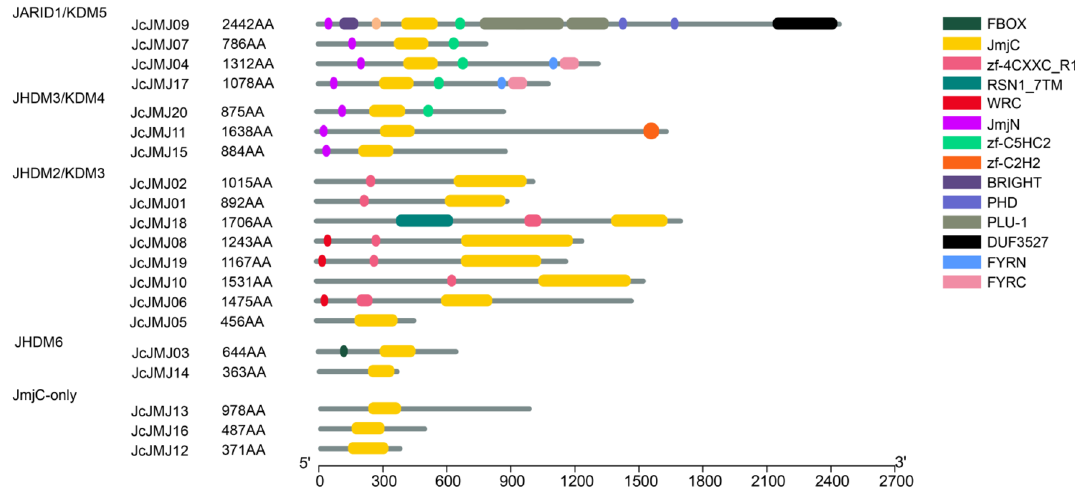
Figure 2. Schematic structure of JmjC domain-containing histone demethylase gene family in J. curcas L. Schematic representation of conserved domains identified among each subfamily of JcJMJs genes. The location and size of domains are shown by different color rectangles as indicated in the